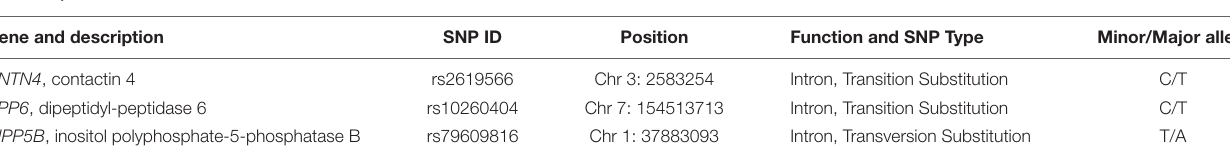
TABLE 4 | Information of three SNPs associated with